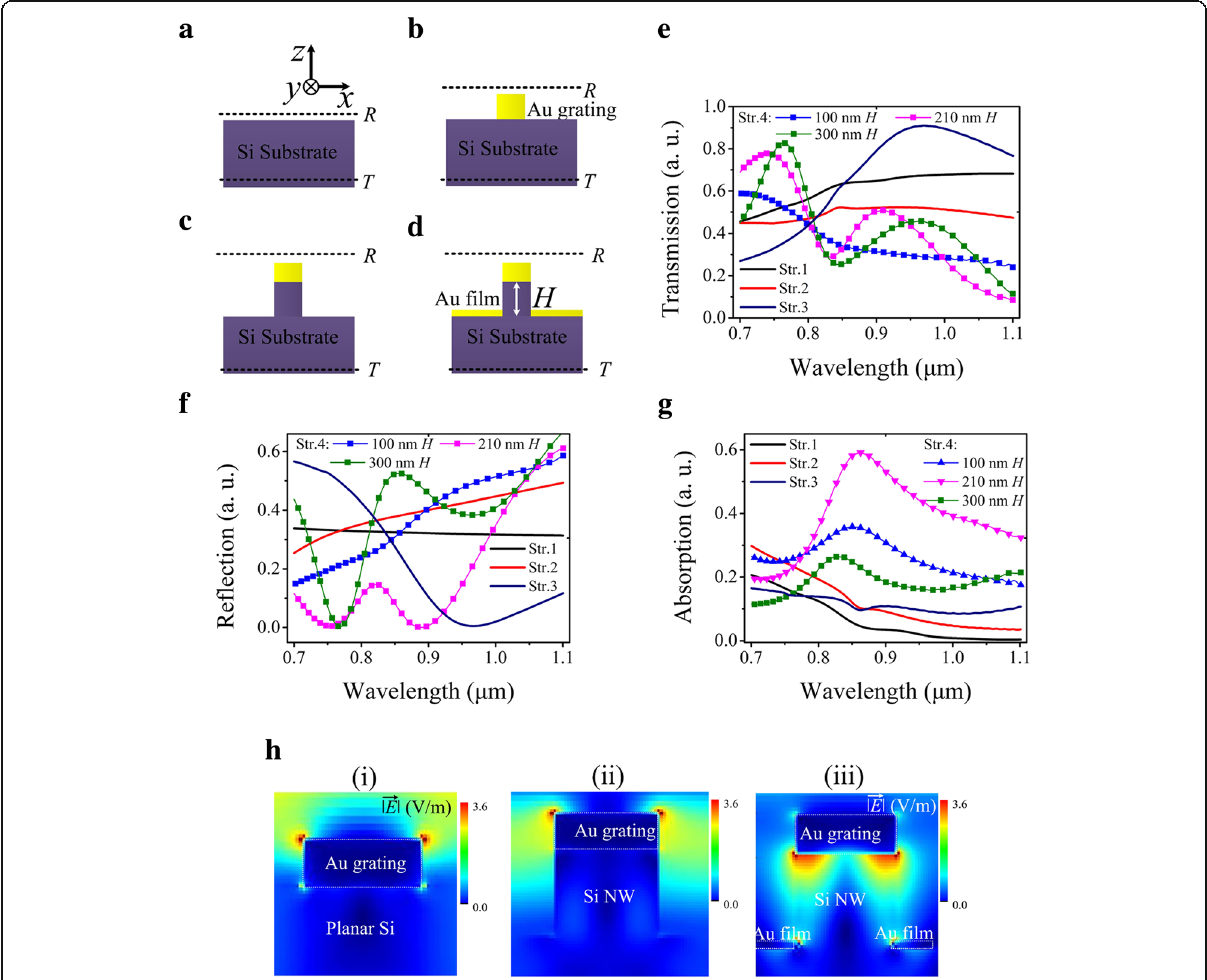
Fig. 2 The diagrams for the four devices investigated in this work and the FDTD simulation results from the devices. a Str.1: the planar Si substrate. ( b ) Str. 2: the Au grating on the top of Si substrate. ( c ) Str. 3: the Au grating on the top of Si NW array. ( d ) Str.4: the completely fabricated detector with both the Au grating on the top and the bottom of the Si NW array. e – g The simulation results for the transmission, reflection, and absorption spectra through the four structures, respectively. h The simulation results for the electric field distributions in the three structures as depicted in b , c , and d , respectively, and the wavelength of the incident light is 860